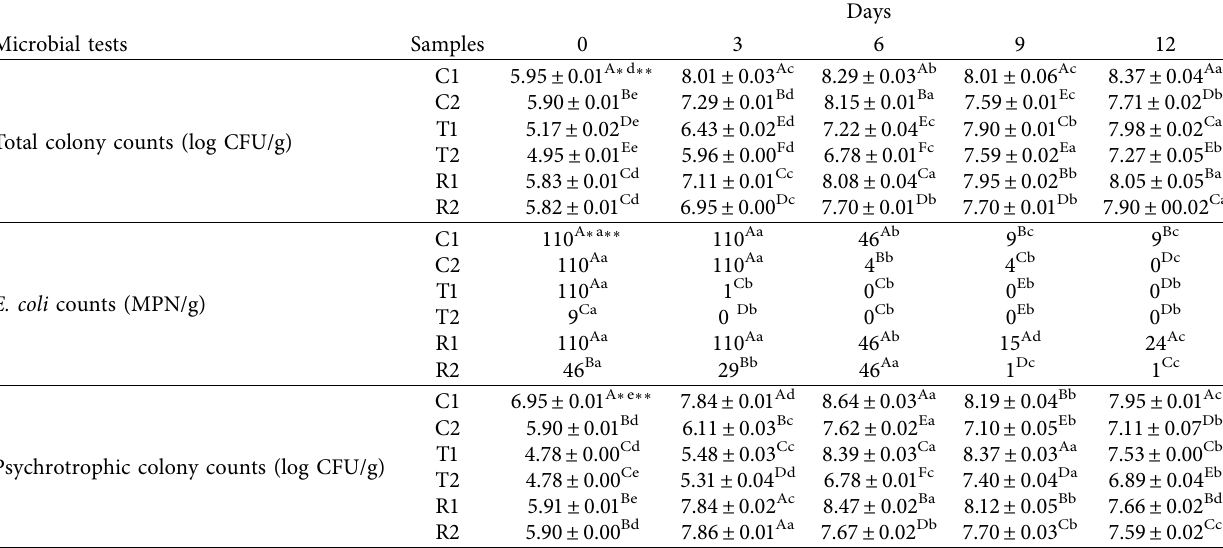
Table 2: Efect of thyme and rosemary EOs on microbial counts of vacuum-packaged chicken breast samples during refrigeration (mean ±